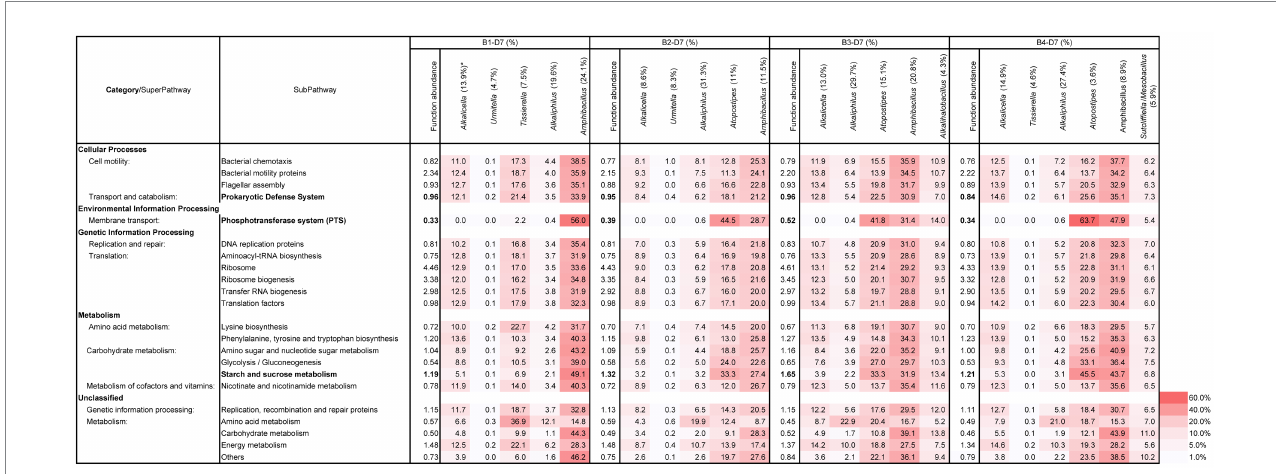
FIGURE 6 Functional abundance ratio (%) of the total subpathways and the contributing ratio (%) of the major constituent taxa in the subpathways related to the initiation and enhancement of indigo reduction at D7 samples in B1–4. *: The number in the parentheses is the existence ratio (%) in the microbiota. The metagenomic prediction produced using PICRUSt2 and BURRITO is shown. The important subpathways and functional abundance ratios are indicated in bold letters. B, batch; D,